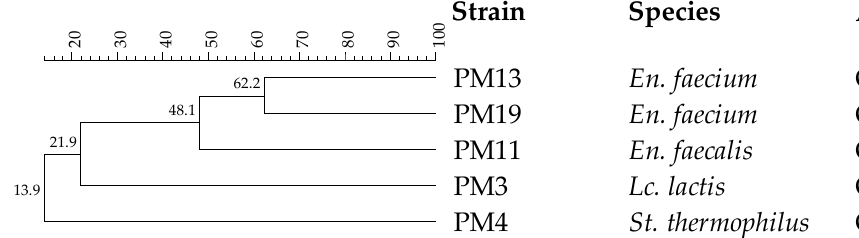
Figure 3. Dendrogram obtained with combined RAPD-PCR patterns generated with three primers for thermoduric indigenous milk LAB strains isolated from pasteurized milk. Abbreviations: En. , Enterococcus ; Lc. , Lactococcus ; St. , Streptococcus .